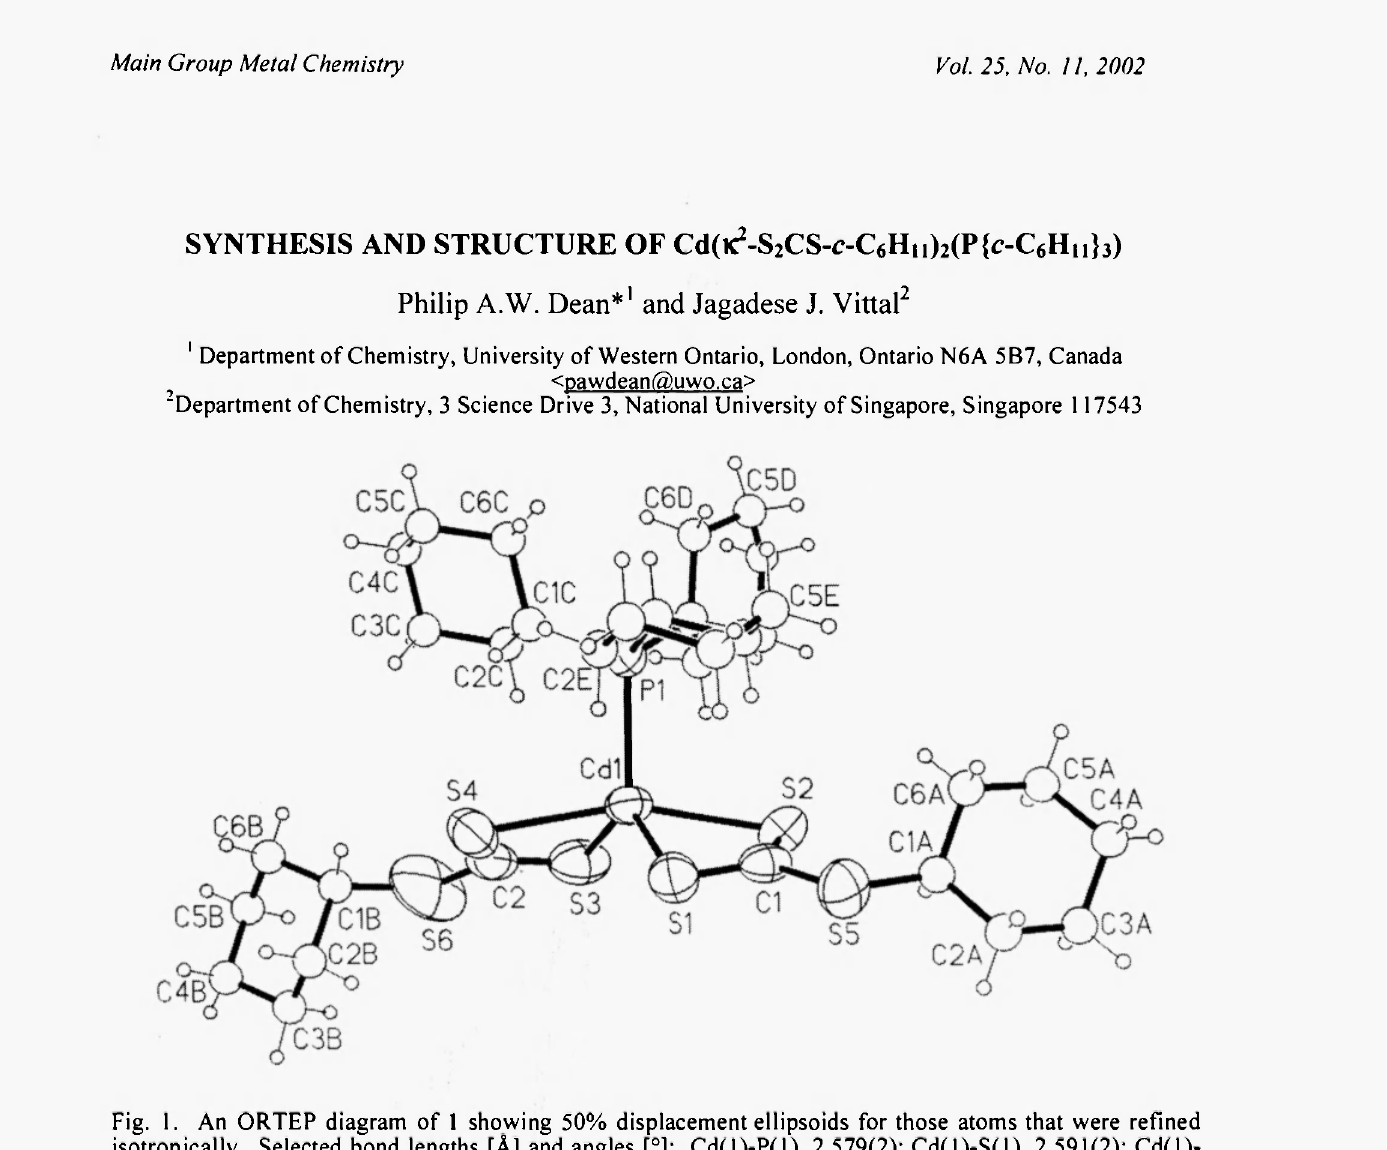
Fig. 1. An ORTEP diagram of 1 showing 50% displacement ellipsoids for those atoms that were refined isotropically. Selected bond lengths [A] and angles [°]: Cd(l)-P(l), 2.579(2); Cd(l)-S(l), 2.591(2);